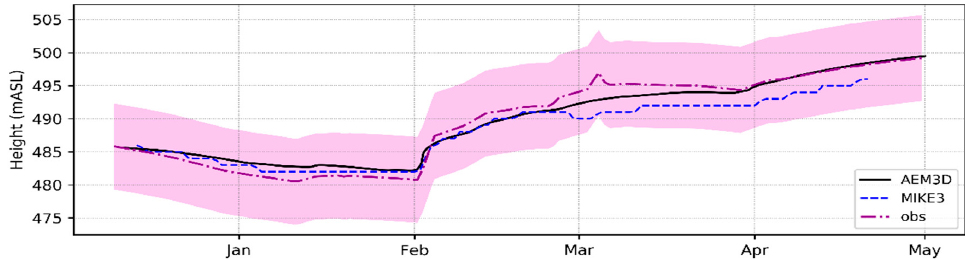
Figure 5. Observed and AEM3D- and MIKE3-simulated Maroon Reservoir water levels over the five-month simulation period. The color band illustrates the range of ± standard deviation of the observed water levels.